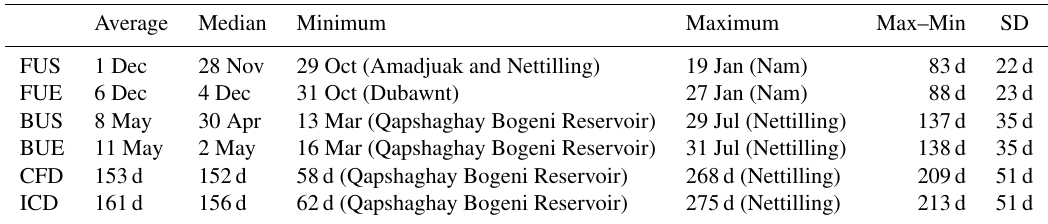
Figure 6. Box plot of the (a) r , (b) bias, and (c) mean absolute error (MAE) results of the comparison between the lake ice phenology dates extracted from the AMSR-E/AMSR2 product and SMMR and SSM/I–SSMIS data. Table 6. Average, median, minimum, maximum, extreme difference (Max–Min), and standard deviation (SD) values of lake ice phenology in the Northern Hemisphere. FUS, FUE, BUS, BUE, CFD, and ICD represent the freeze-up start date, freeze-up end date, breakup start date, breakup end date, complete freezing duration, and ice cover duration,